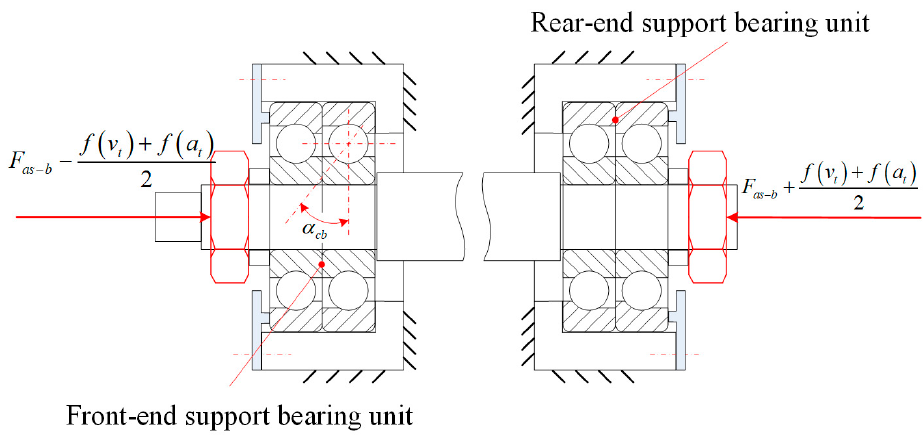
Figure 4. Assembly structure of the support bearing units of a feed system.